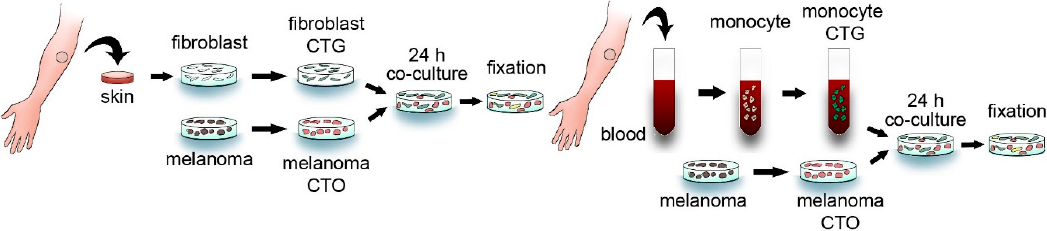
Figure 1. In vitro cell fusion model. Primary human dermal fibroblasts ( left panel ) or human peripheral blood-derived monocytes ( right panel ) labeled with CellTracker Green (CTG) were co-cultured with human melanoma cells labeled with CellTracker Orange (CTO) for 24 h. The samples were subsequently fixed and analyzed with a fluorescent microscope.